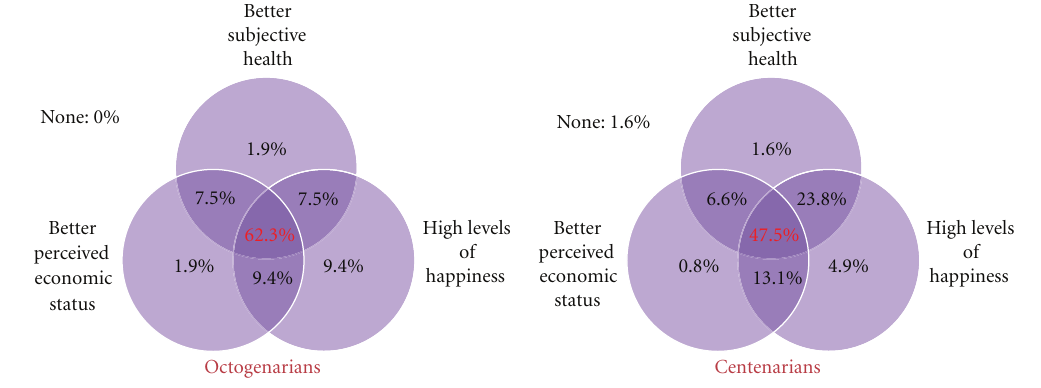
Figure 2: Drawings of age group comparisons for alternative successful aging model between octogenarians and centenarians. Numbers represent the proportion of each age group satisfied with components of the alternative successful aging model.